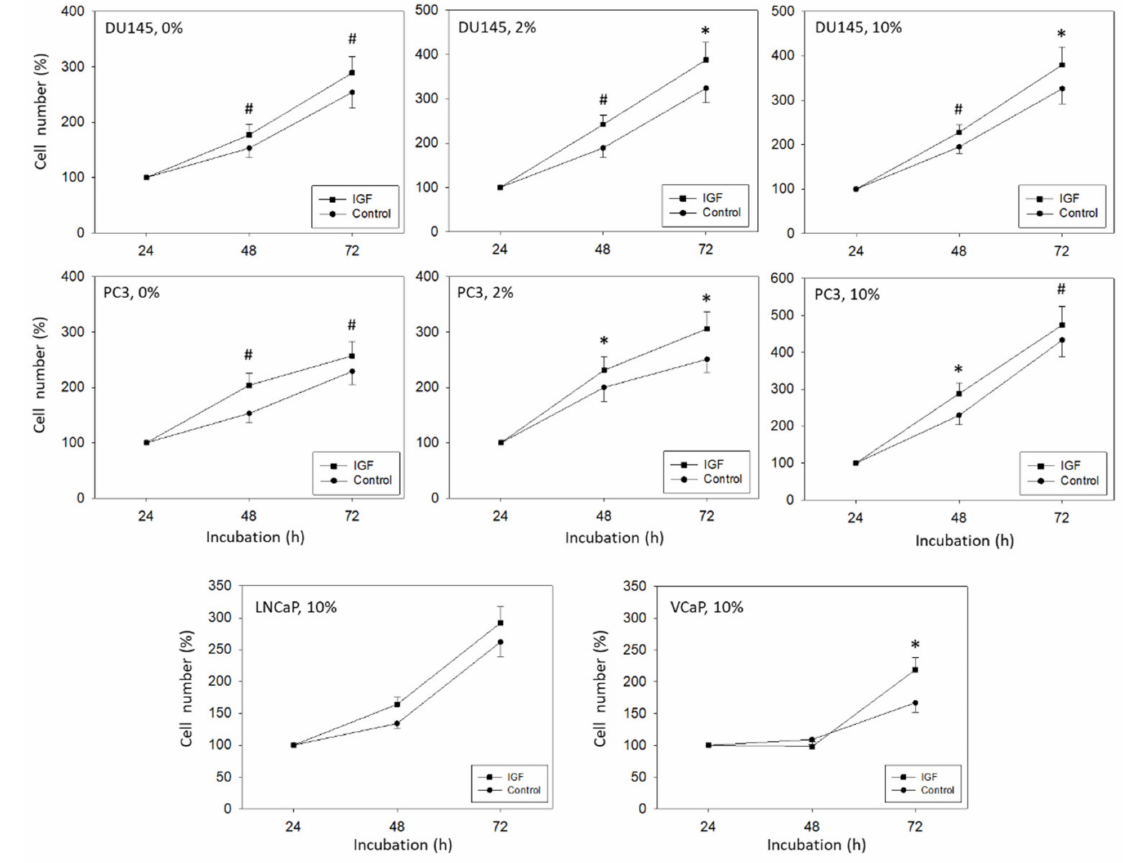
Figure 2. DU145, PC3, LNCaP, and VCaP cell growth in response to IGF-1. DU145 and PC3 cells were grown in FBS free medium (0%), in medium containing 2% FBS (2%) or 10% FBS (10%). LNCaP and VCaP were cultivated in the presence of 10% FBS. Untreated cells served as controls. Cell number was evaluated after 24, 48, and 72 h by the MTT assay. Error bars indicate standard deviation. Experiments were repeated five times. One representative experiment is shown. * indicates p < 0.05, # indicates p <